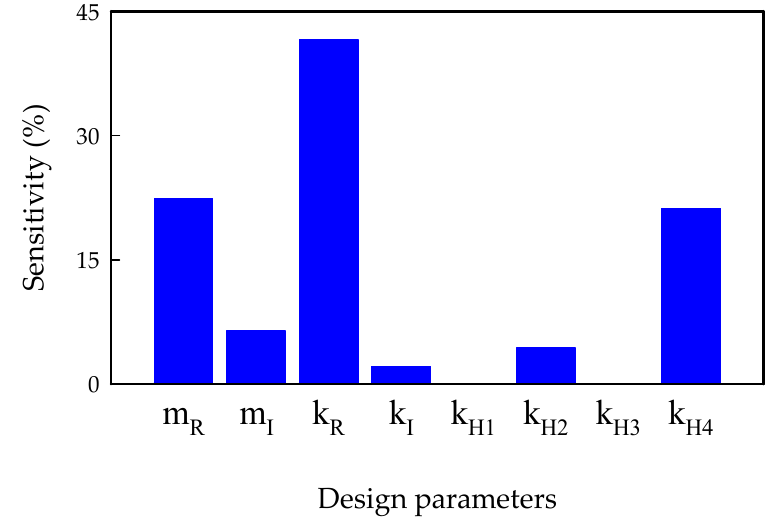
Figure 20. Results of the sensitivity analysis for the variations of each design variable. To minimize the idle vibration level, the optimal design was implemented within the range constraints of the design variables. The design was optimized using the progressive quadratic response surface modeling (PQRSM) method, which is included in the commer ‐ cial design optimization software package PIAnO [28]. To perform the design optimiza ‐ tion using the eight design variables listed in Table 4, the idle vibration level was selected as the objective function, and these design variables were varied from their lower to upper limits, as depicted in Table 4. The convergence results of design optimization are shown in Figure 21, in which the lower and upper dashed lines represent the minimum and max ‐